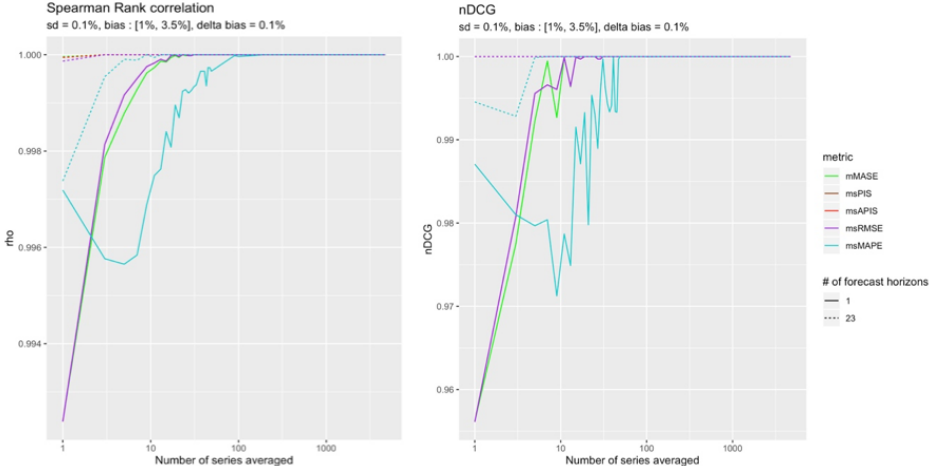
Figure 18. Spearman Rank correlation and nDCG for ( − + + ) configuration.